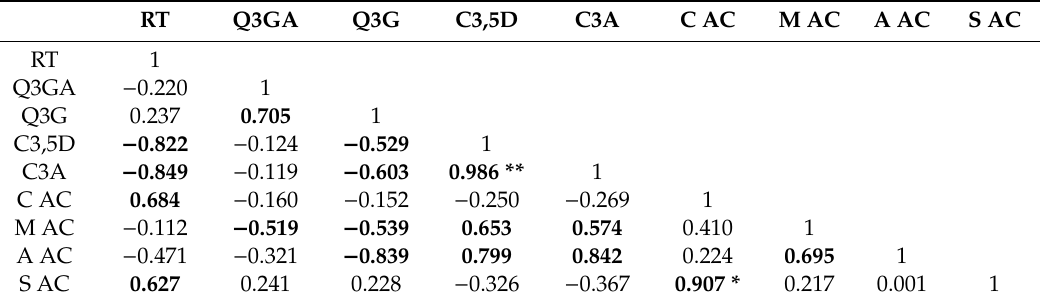
Table 10. Correlation coe ffi cients among biochemical parameters analyzed.